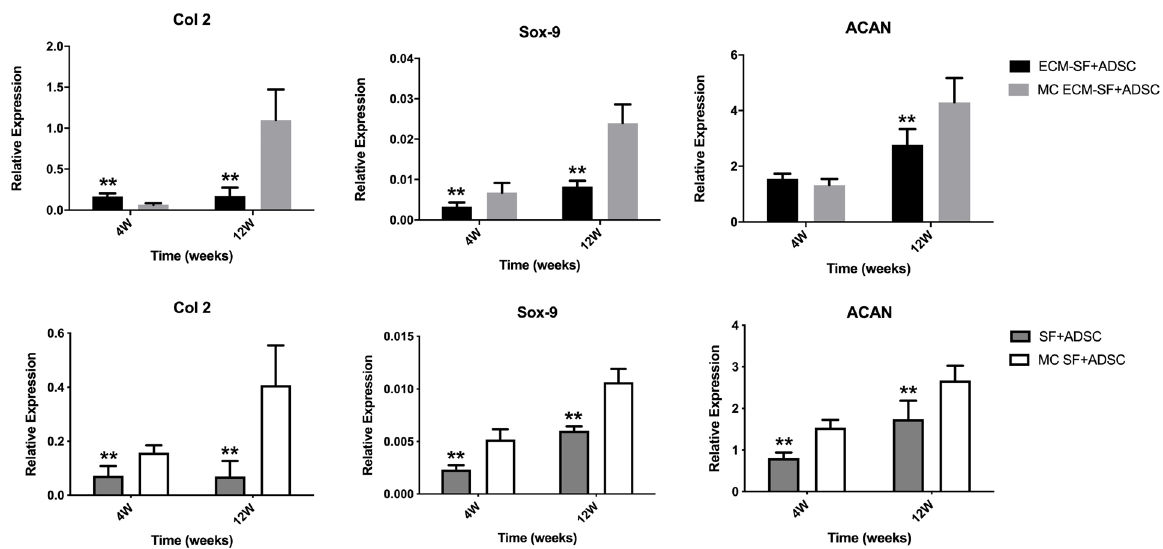
Figure 7. mRNA expression of chondrogenic-related genes examined with qPCR in solid hydrogel and MC hydrogel. “**” indicates significant difference between the two groups with p < 0.01.